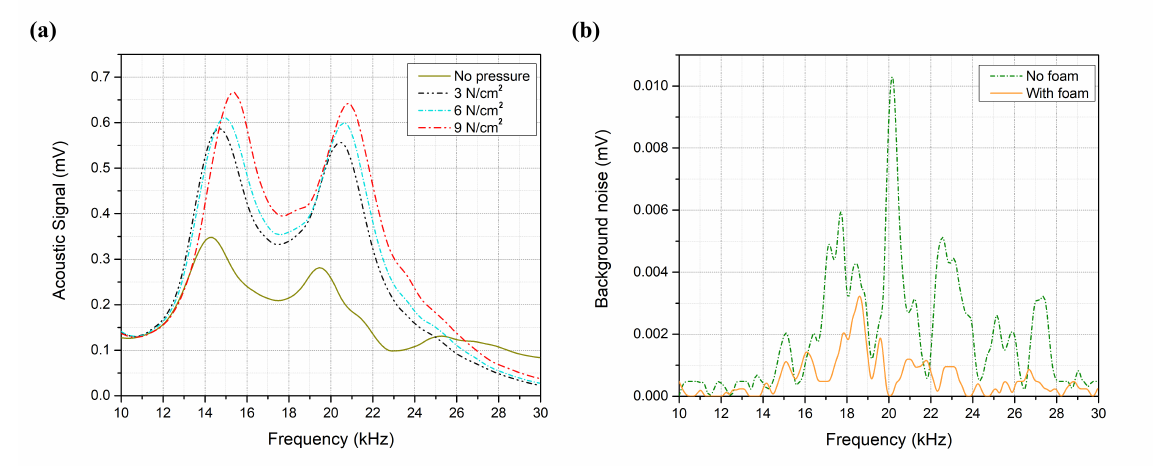
Figure 6. ( a ) Background noise with and without acoustic absorption foam. ( b ) Acoustic spectrum at different pressure